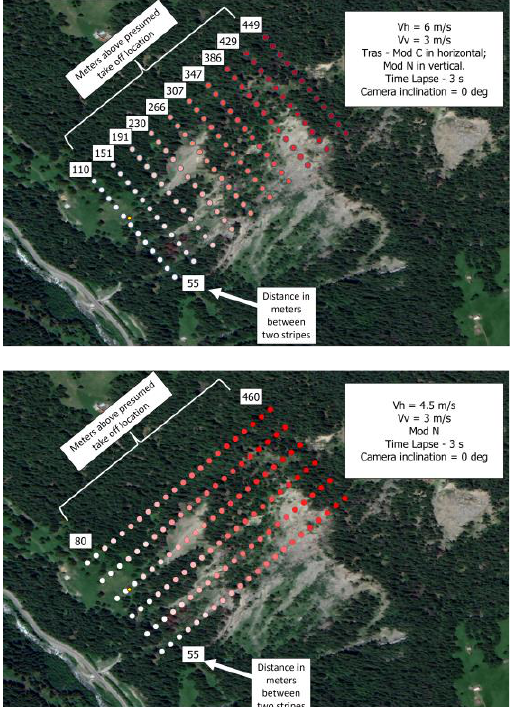
Figure 3. Flight plans in translational and longitudinal direction. ( basemap - Google Satelite through QuickMapServices QGIS plugin, Map data © Google